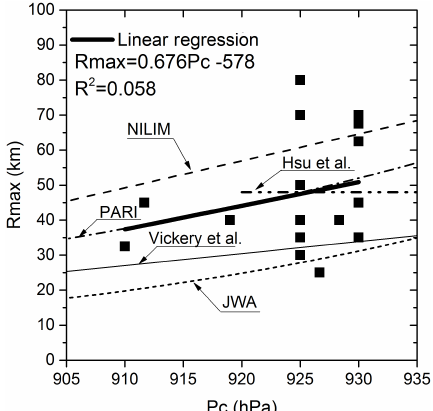
Figure 3. Wind radii and central pressures of 17 tropical cyclones and estimations from the National Institute for Land and Infras- tructure Management (NILIM), Port and Airport Research Insti- tute (PARI), Japan Weather Association (JWA), Hsu and Yan (1998) models, and Vickery and Wadhera (2008).